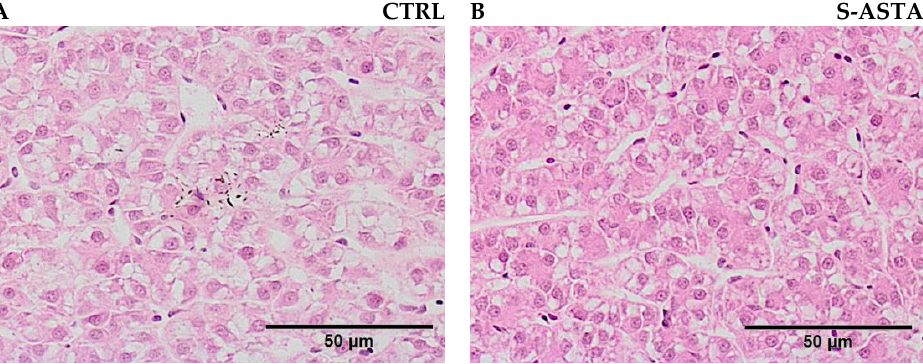
Figure 2. Liver morphology of rainbow trout fed a diet without (CTRL, ( A )) and with astaxanthin (S-ASTA, ( B )) for 12 weeks (stained with haematoxylin and eosin).